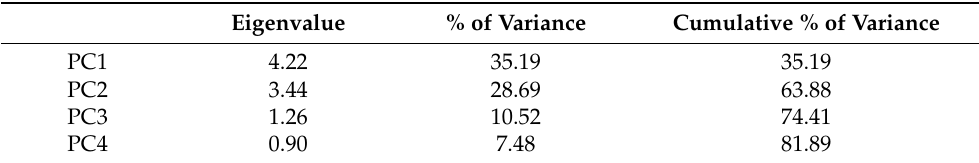
Table 5. The eigenvalues and the proportion of variances explained by the principal components